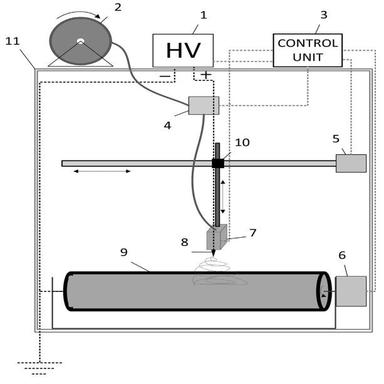
Schematic of fibre printing melt electrospinning apparatus.